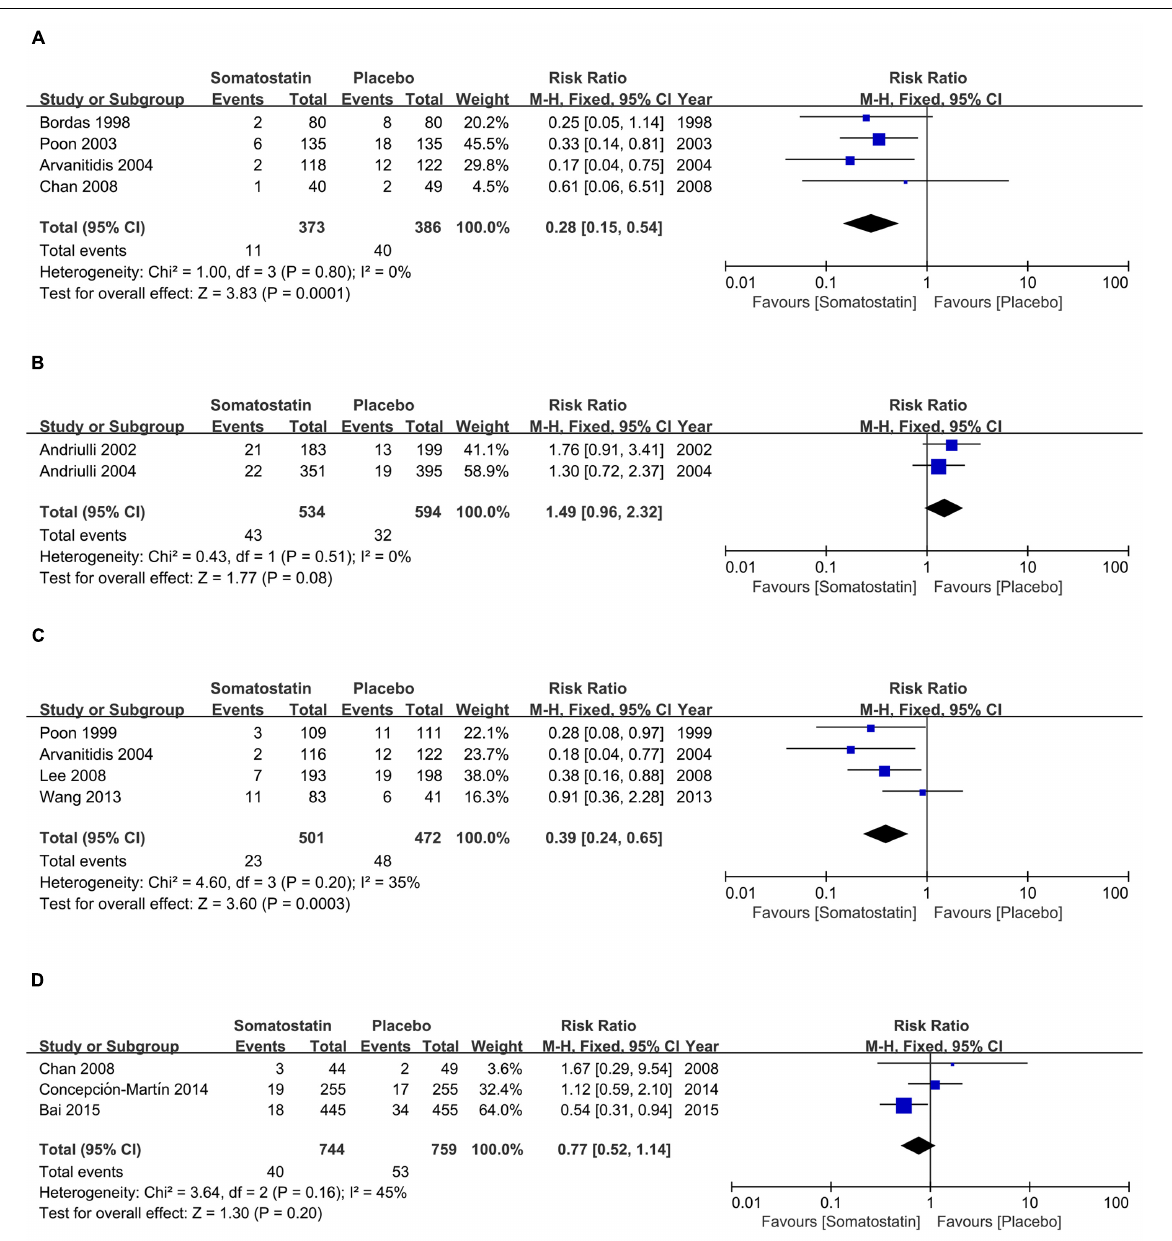
funnel plot of hyperamylasemia was also applied. Publication bias was found in the outcome of hyperamylasemia ( Figure 8B